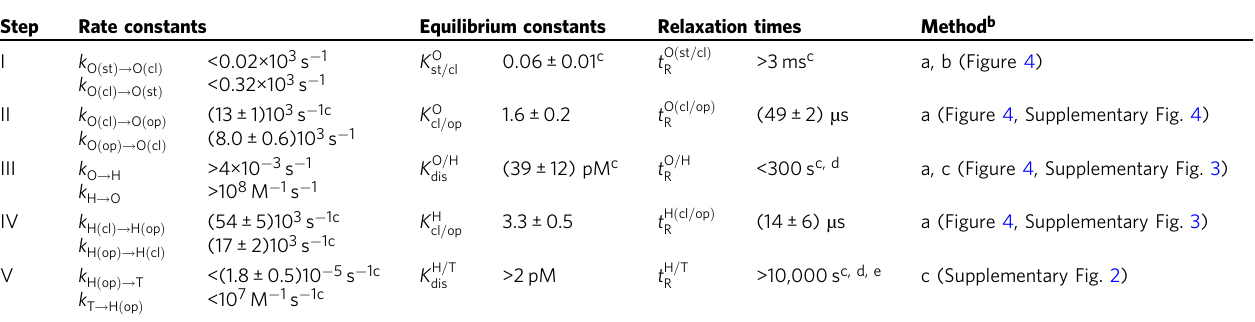
Table 1 Kinetic and thermodynamic parameters of the nucleosome disassembly at 150 mM NaCl a